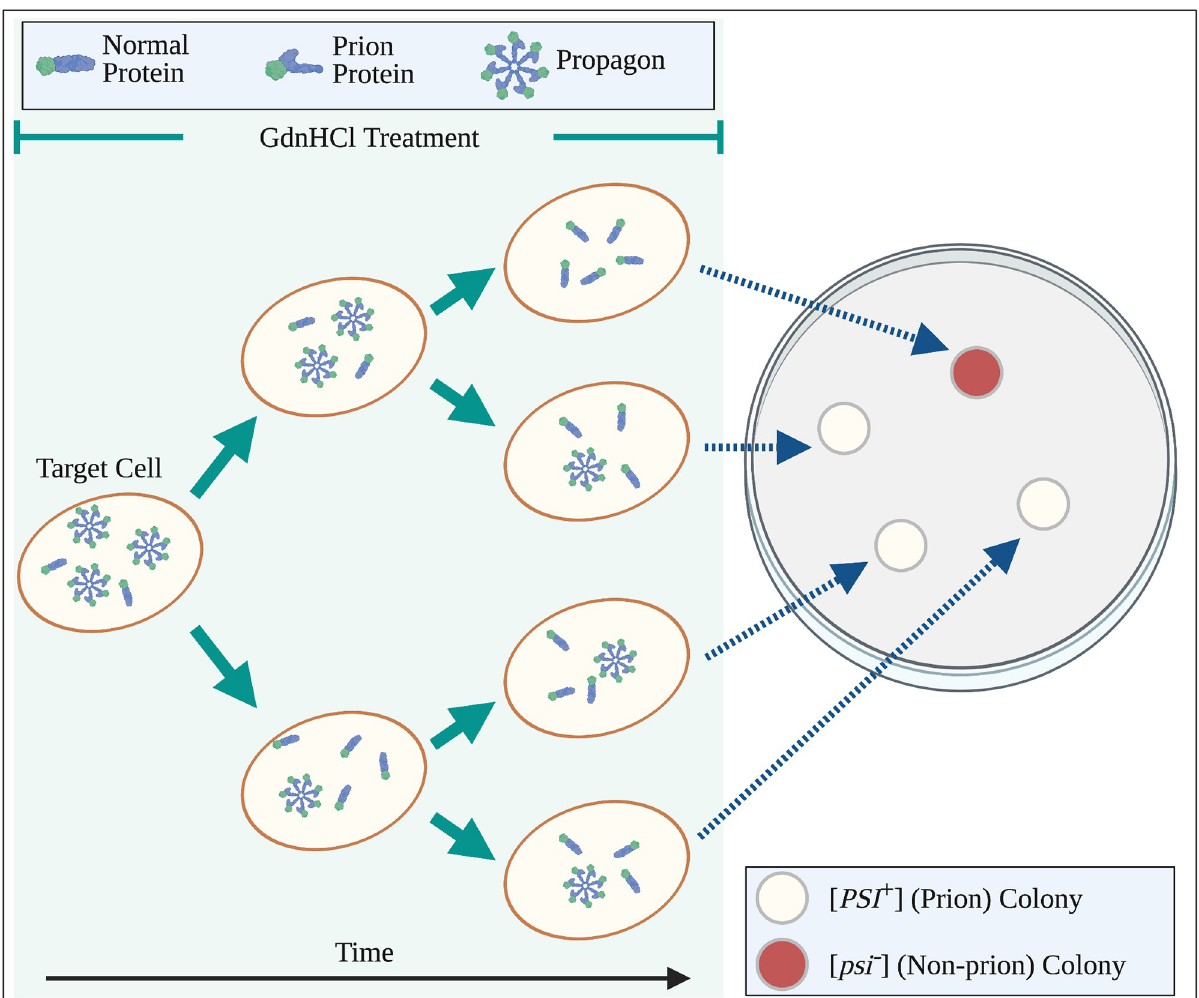
Fig 2. Propagon amplification assay. A two-step process is used to count the number of transmissible prion aggregates (propagons) in a single cell. Left : A single target cell is isolated, and propagon fragmentation is stopped through exposure to GdnHCl. Since propagons (pinwheels) cannot increase in number, they are diluted through cell division (green arrows). Right : After sufficient dilution, i.e. each yeast cell is likely to contain at most one propagon, the colony is replated onto solid media. In the absence of GdnHCl, each single cell serves as a founder of a distinct yeast colony. The number of propagons in the target cell corresponds to the number of white colonies in the